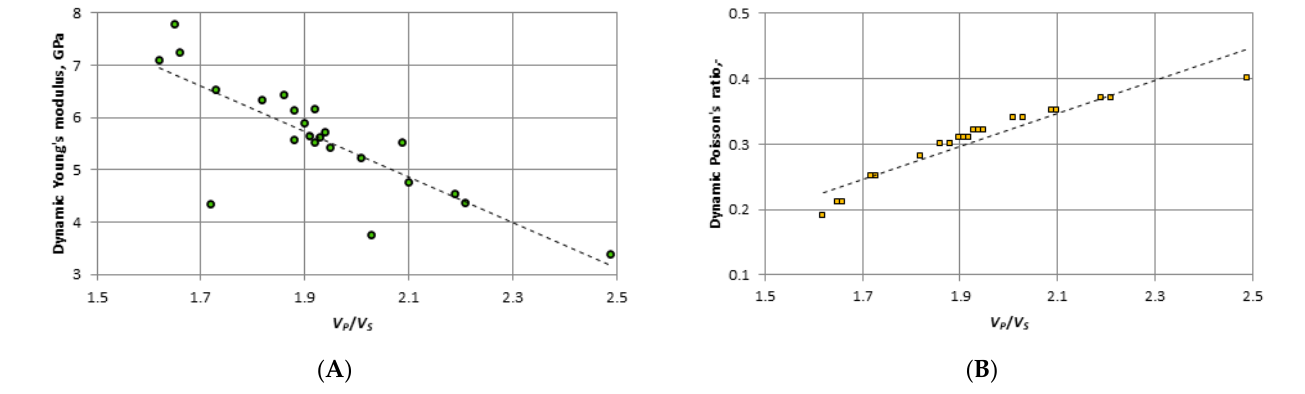
Figure 10. Linear dependences for the tested coals: ( A ) E dyn = f ( V P /V S ); ( B ) ν dyn = f ( V P /V S ).